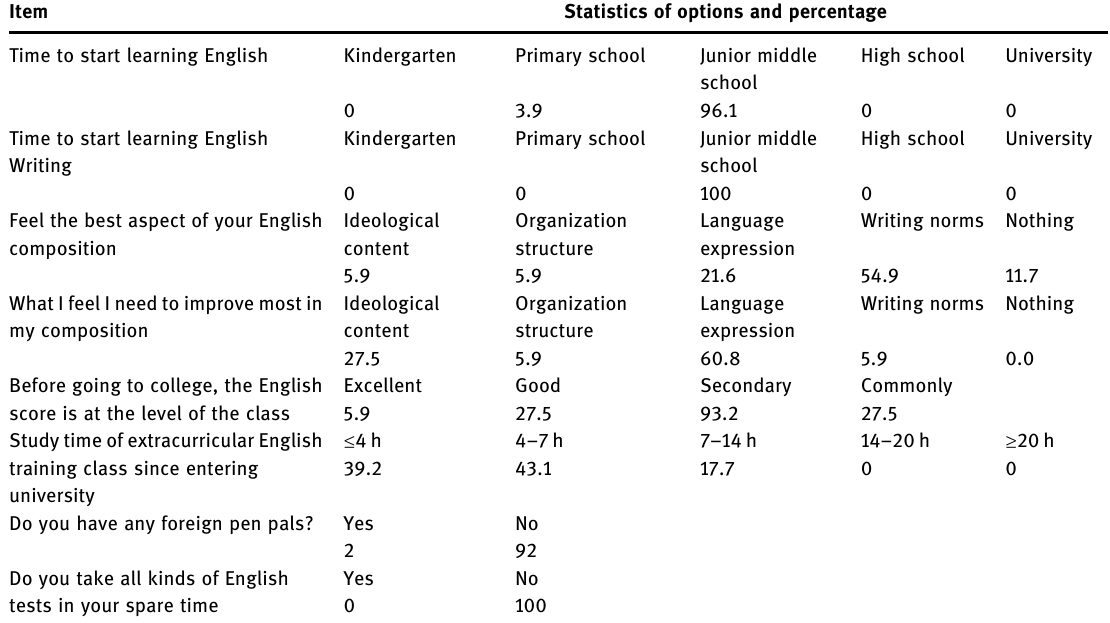
Table 4: Survey of students ’ English writing learning Item Time to start learning English